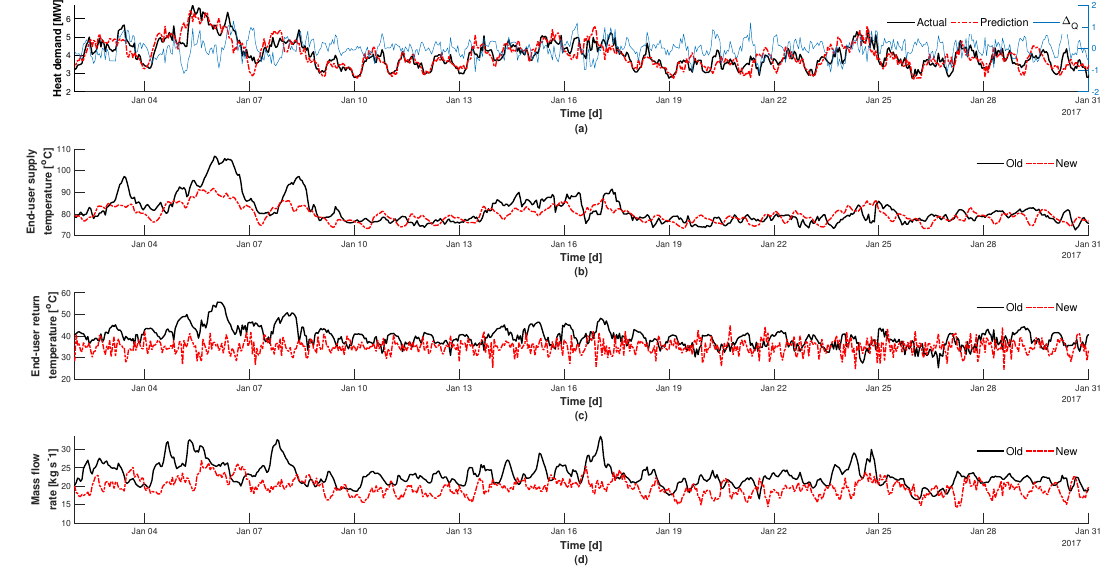
Figure 7. Control results for Scenario 2, using load prediction. ( a ) predicted load in relation to the actual load, ( b ) supply temperature to the end-user, ( c ) temperature leaving the end-user, and ( d ) mass flow rate of heat being